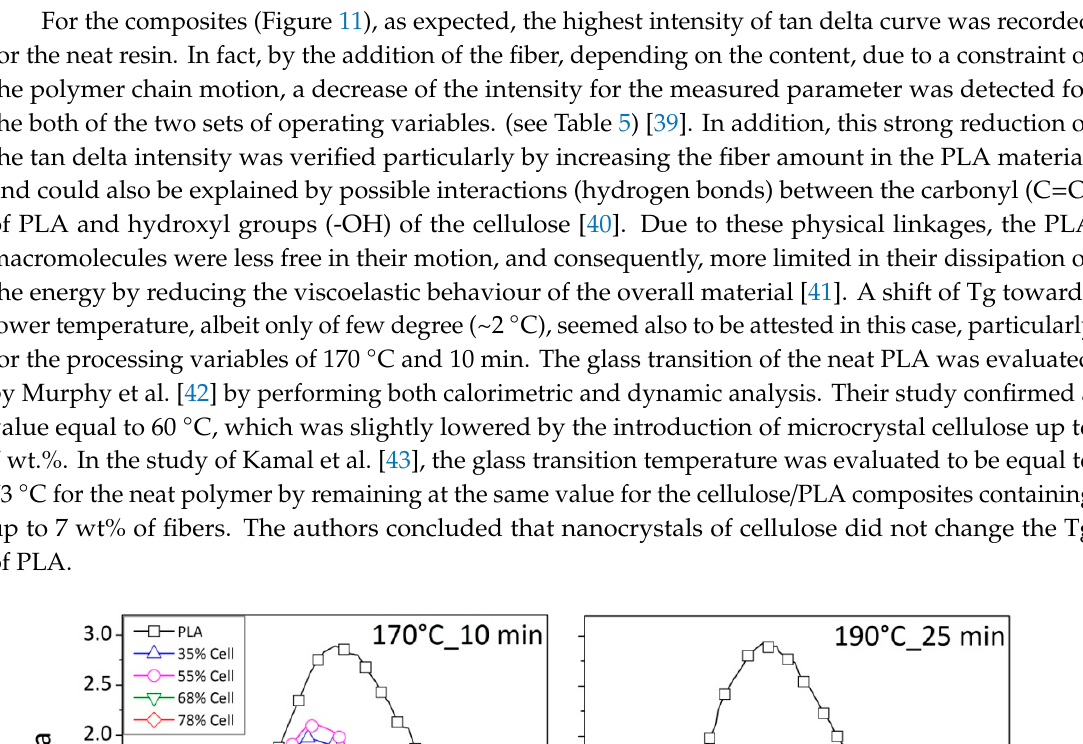
Figure 10. Variation of the storage modulus ( a ) and damping factor ( b ) as a function of temperature at 1 Hz for the PLA samples processed in different mixing conditions. Legend in Figure 10b as in Figure 10a.